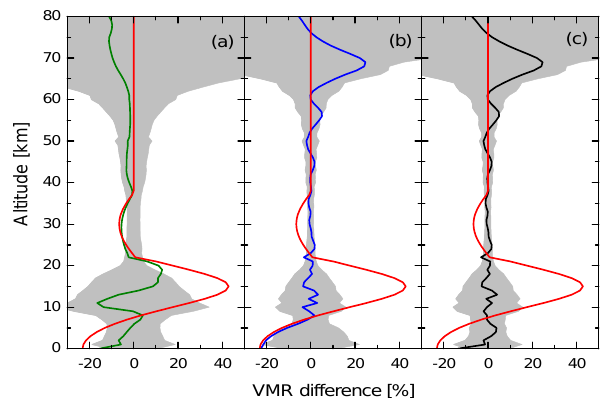
Fig. 2. Percentage differences in the simulated case between the profiles retrieved using only the IASI measurement (green line in (a) ), only the MIPAS measurement (blue line in (b) ), the IASI- MIPAS data fusion (black line in (c) ) and the true profile. The gray areas represent the percentage retrieval errors of the three retrieved profiles. For comparison in all panels the percentage difference be- tween the climatological profile and the true profile is shown (red lines).